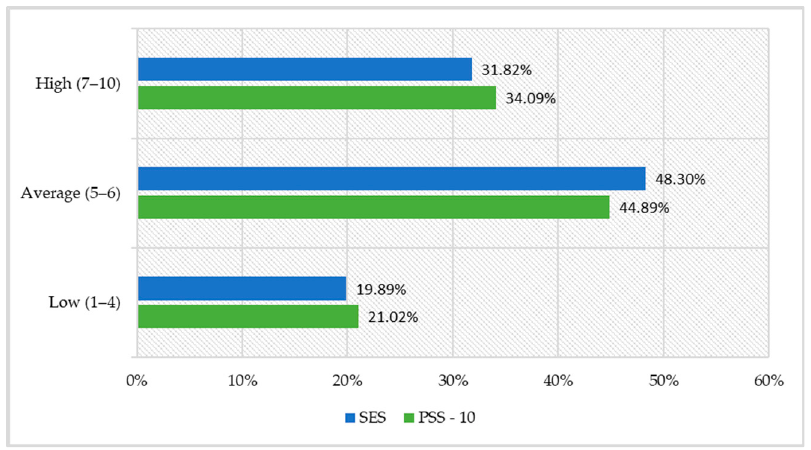
Figure 1. Distribution of global self ‐ esteem scores and the level of perceived stress among the nurses in the study.